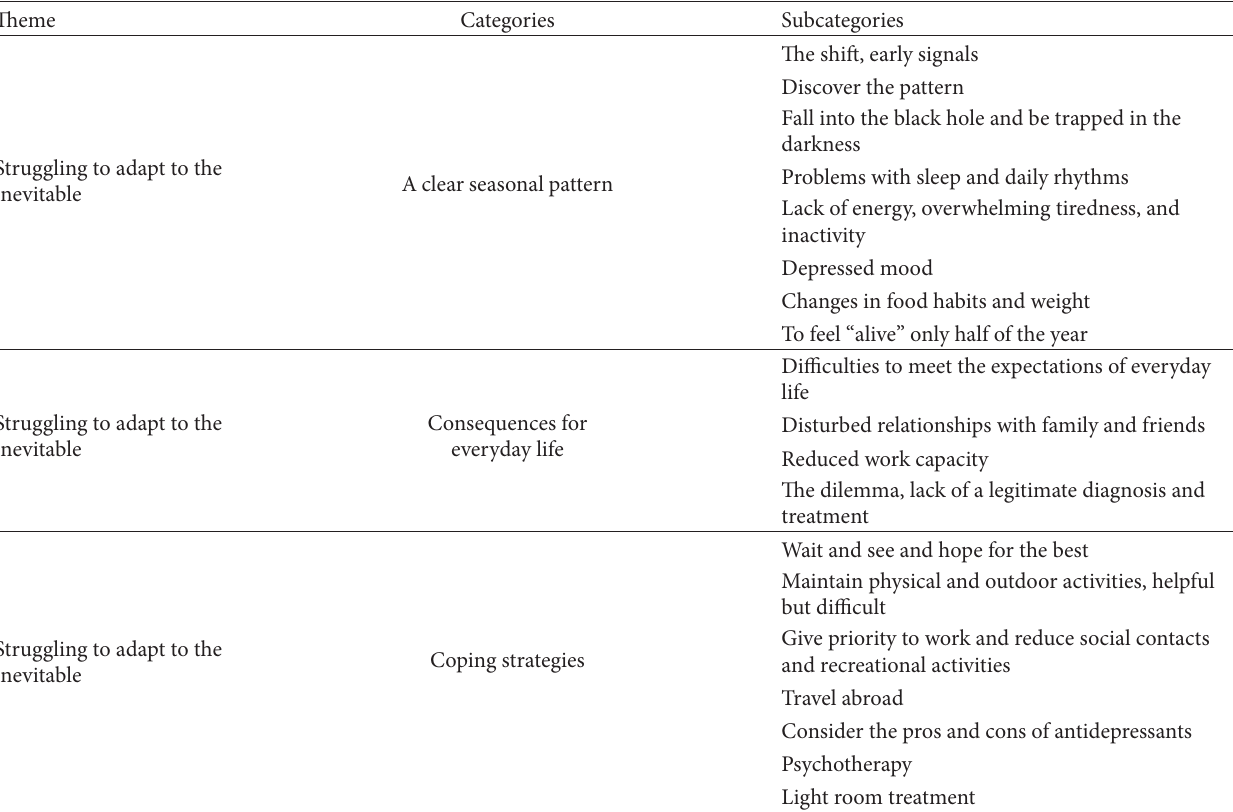
Table 2: Overview of the results regarding patients’ experience of seasonal affective disorder: one main theme, three categories, and 19 subcategories ( 𝑁 = 18 ).